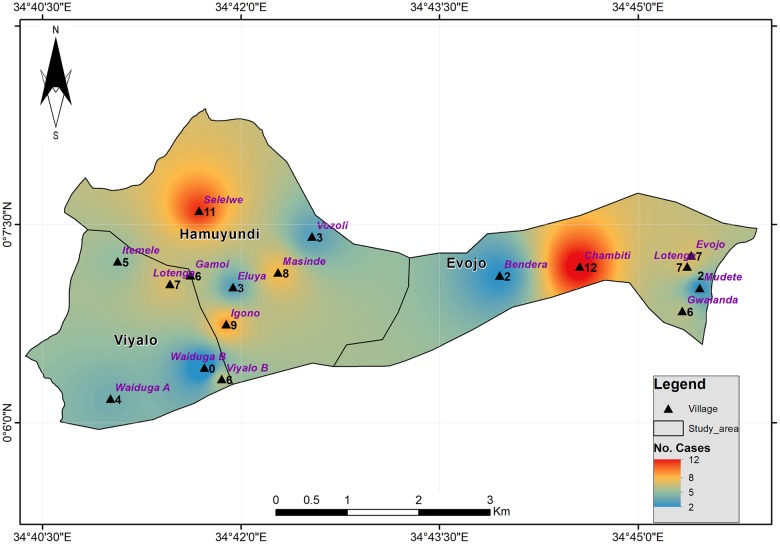
Distribution of cases.